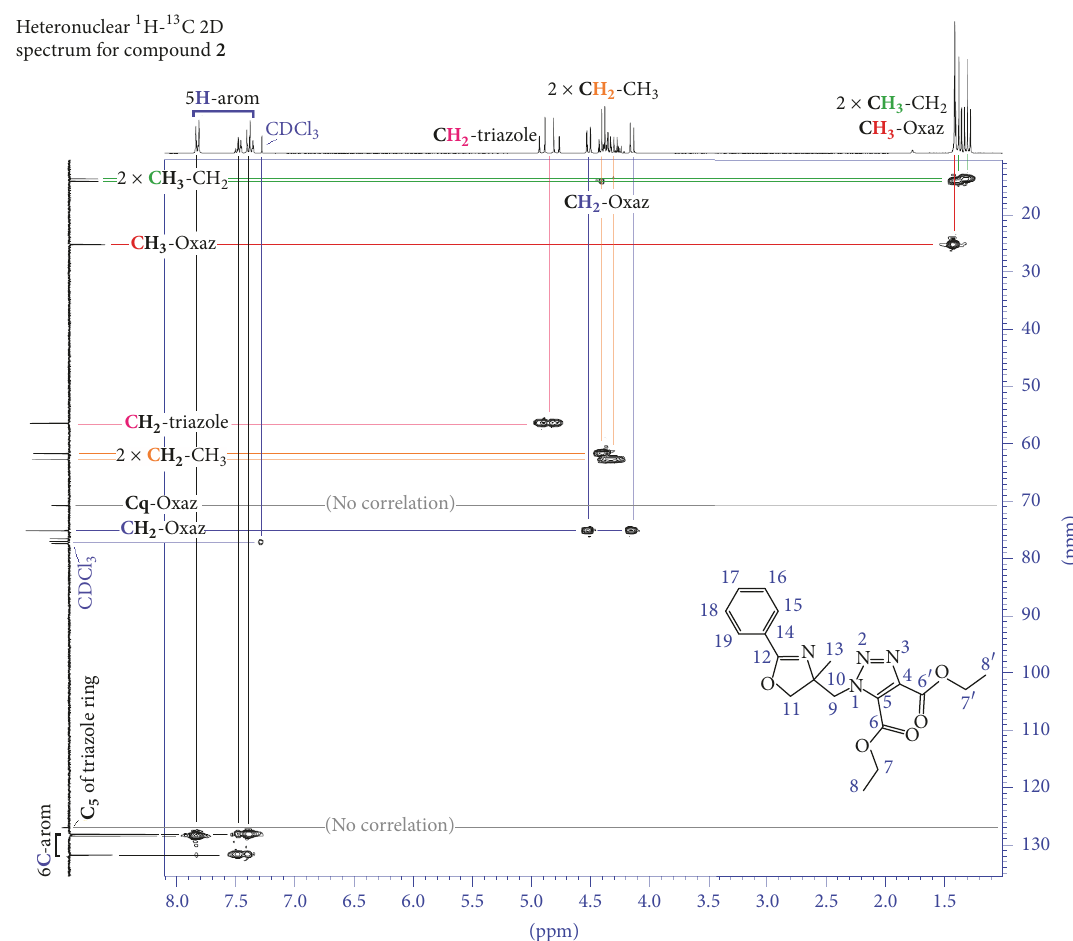
Figure 2: 1 H- 13 C 2D correlation spectroscopy identifies coupling between protons and carbons in compound 2 .